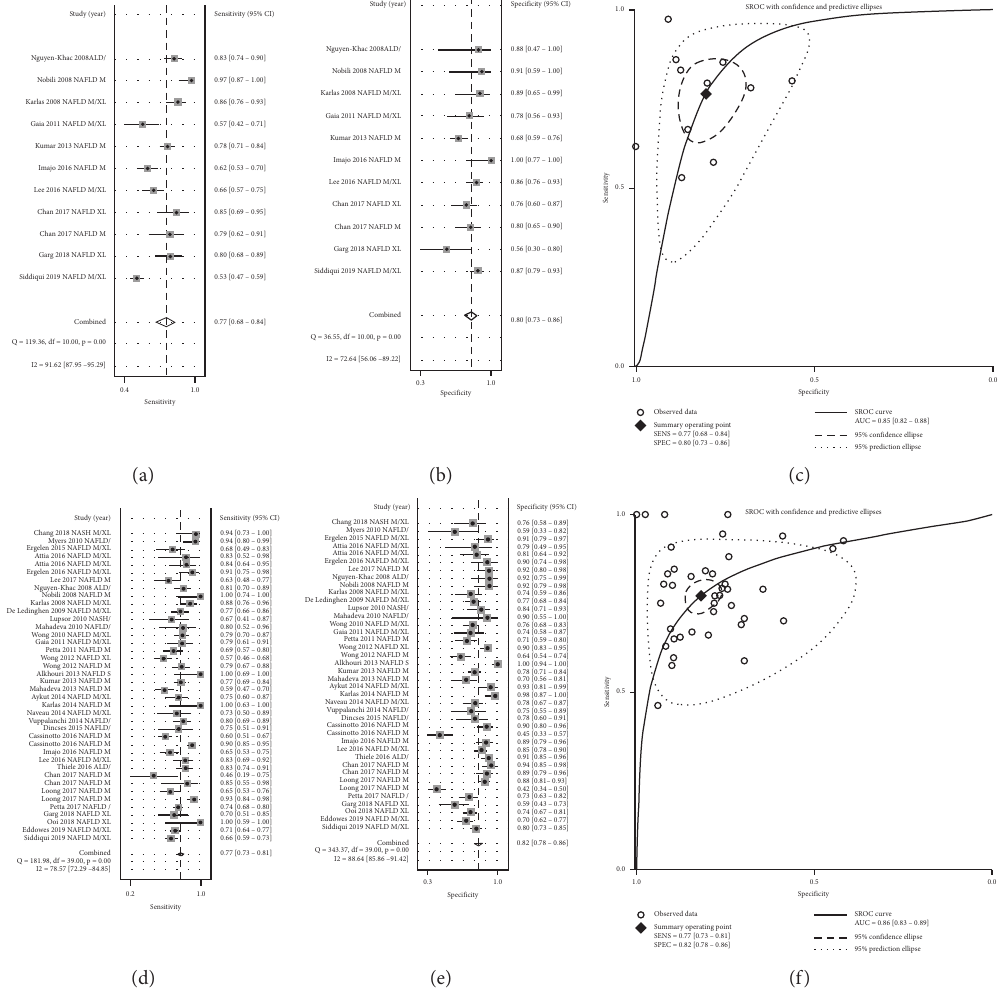
Figure 3: Diagnostic performance of LSM for liver fibrosis in alcoholic liver disease/nonalcoholic fatty liver disease. (a) Sensitivity, (b) specificity, and (c) summary receiver-operating characteristics (SROC) curve of LSM for identifying patients with fibrosis grade ≥ F 1. (d) Sensitivity, (e) specificity, and (f) SROC curve of LSM for identifying patients with fibrosis grade ≥ F 2. LSM: liver stiffness measurement; SROC: summary receiver-operating